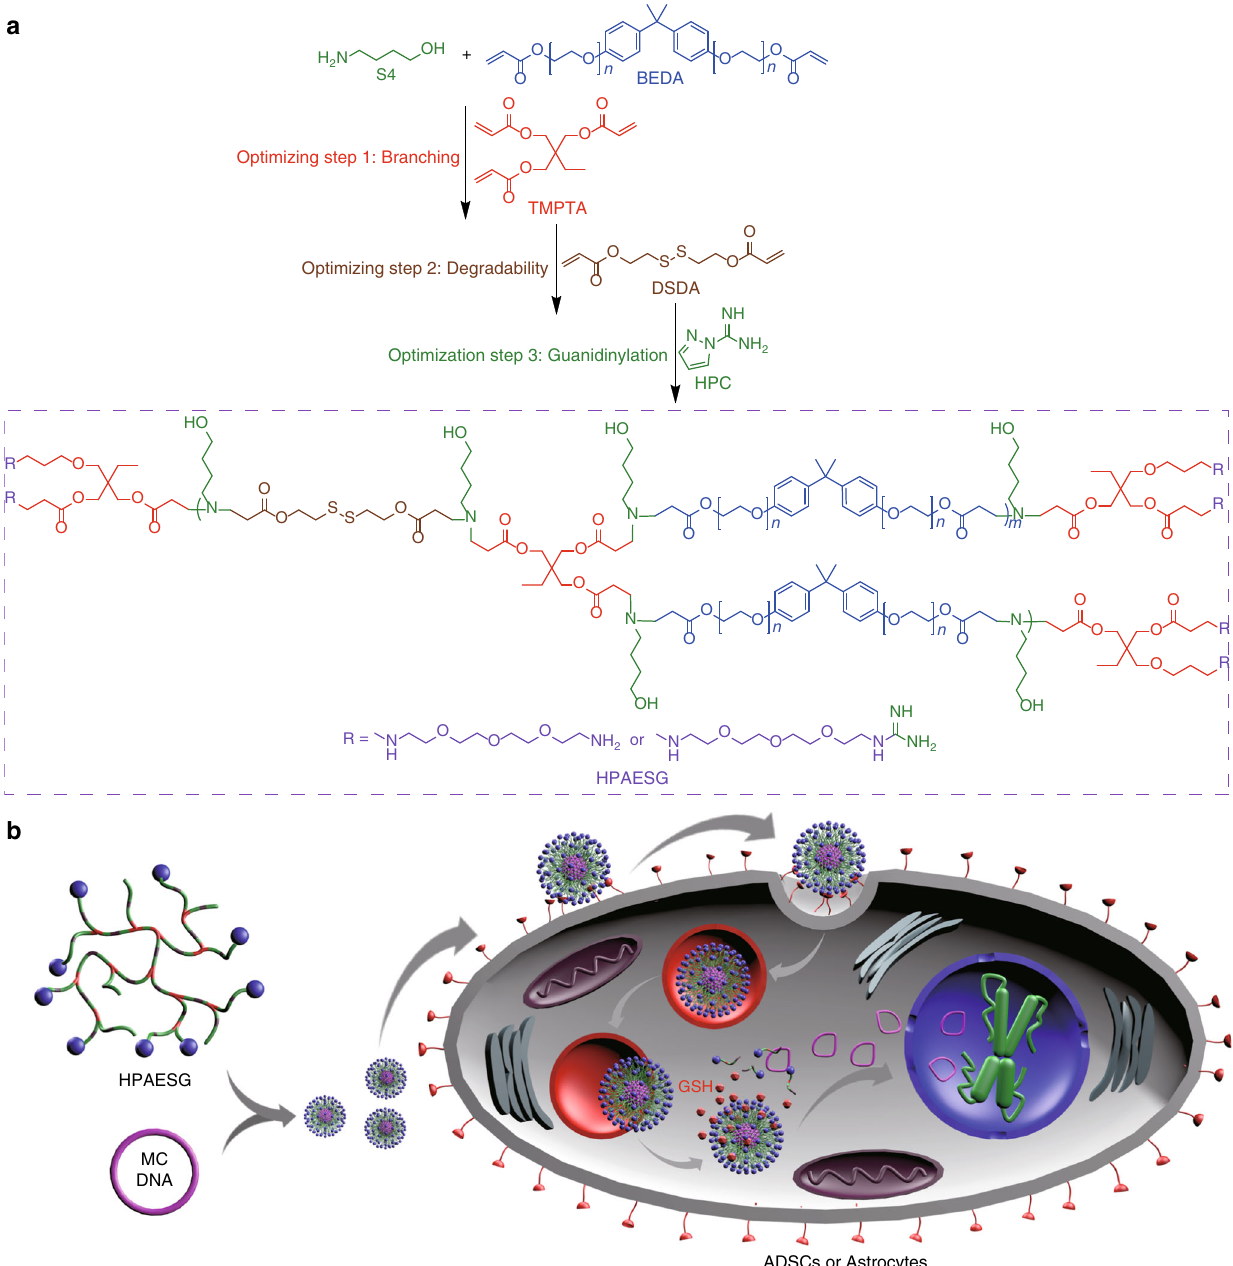
Fig. 1 A synergistic gene delivery system for the transfection of ADSCs and astrocytes. a Iterative optimization of the branched structure, biodegradability, and guanidinylation identi fi es the leading HPAESG with high biocompatibility, enhanced cellular penetrating ability, and DNA release controllability. b The leading HPAESG condenses MC DNA to formulate nano-sized polyplexes, which can enter cells with high ef fi ciency. After escaping from endo/lysosomes, the polyplexes are disassociated by glutathione (GSH)-mediated cleavage to release DNA, allowing safe and ef fi cient gene transfection of ADSCs and